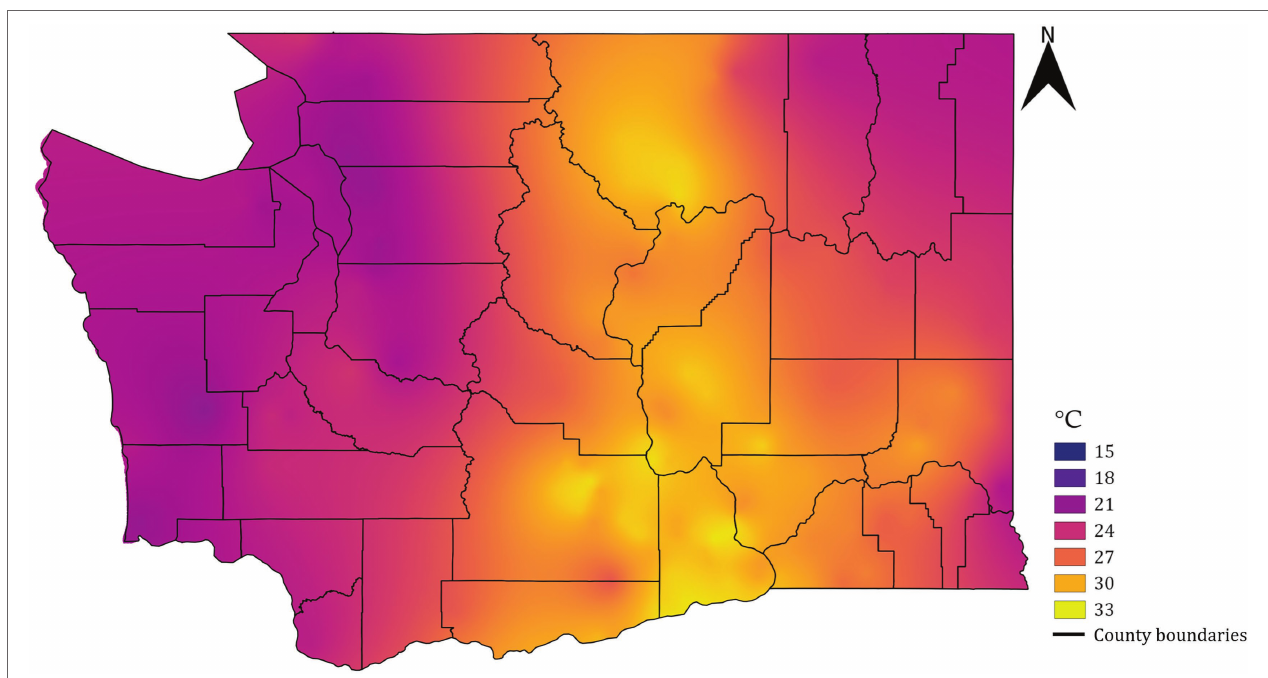
FIGURE 2 | Raster map of mean daily maximum soil temperature data for Washington state within the June 1 to August 31 period averaged for 11 years (2010–